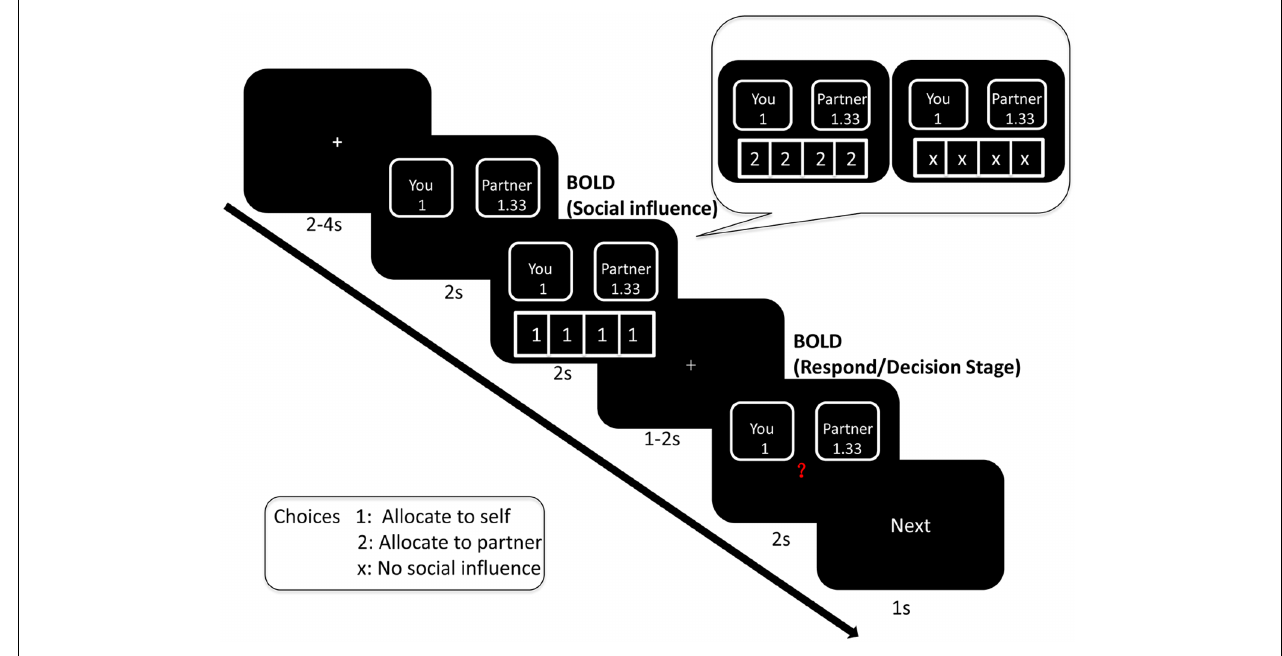
FIGURE 1 | Illustration of sequence of stimuli in one trial (take generous offer trial for example).